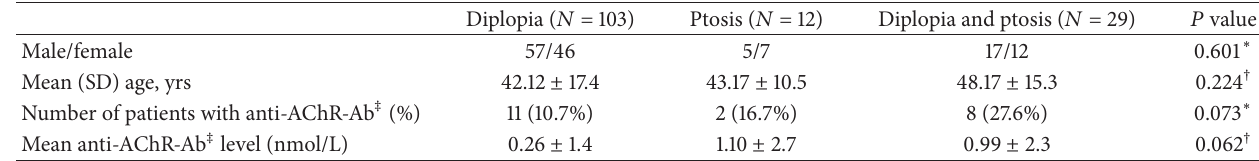
Table 1: The characteristics of each group.